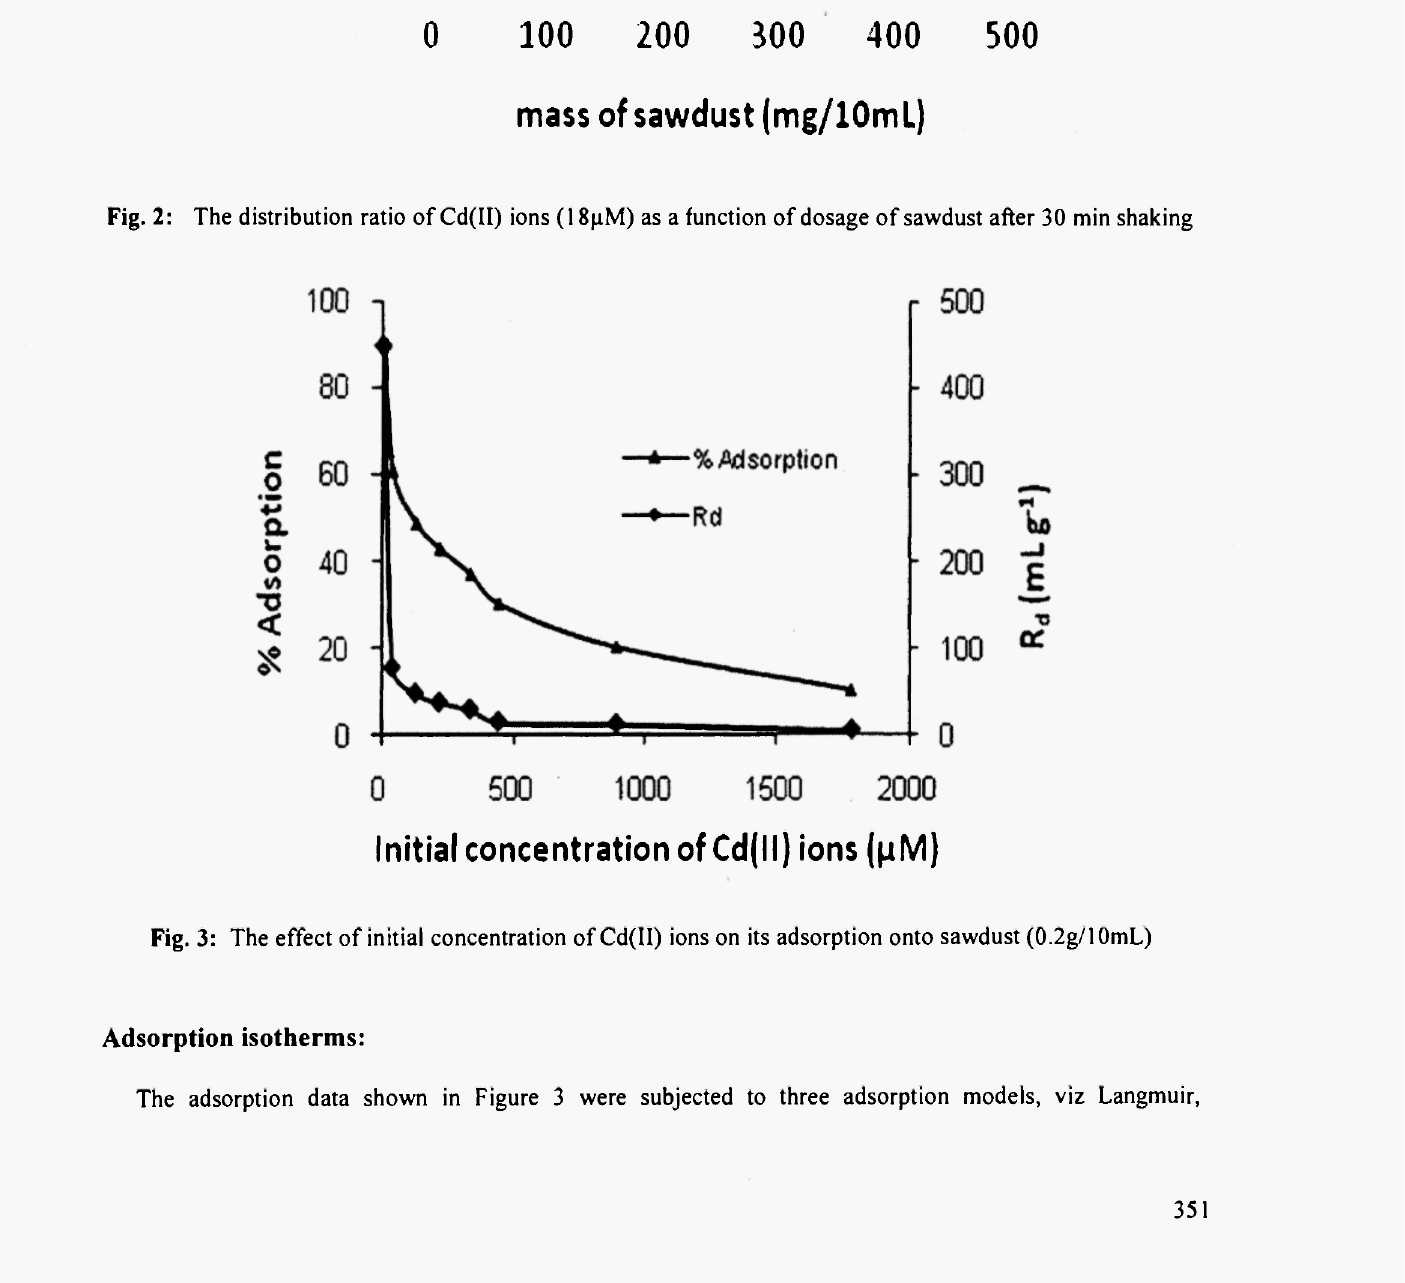
Fig. 3: The effect of initial concentration of Cd(II) ions on its adsorption onto sawdust (0.2g/10mL)